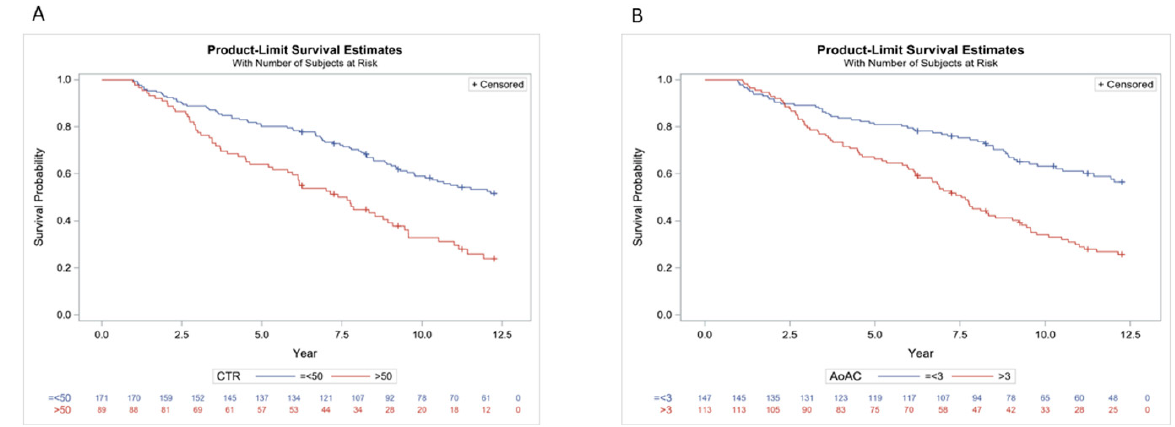
Figure 4. Kaplan–Meier analysis of overall mortality according to ( A ) CTR > 50% or ≤ 50%, and ( B ) AoAC > 3 or ≤ 3 in study patients (all log-rank p < 0.0001).